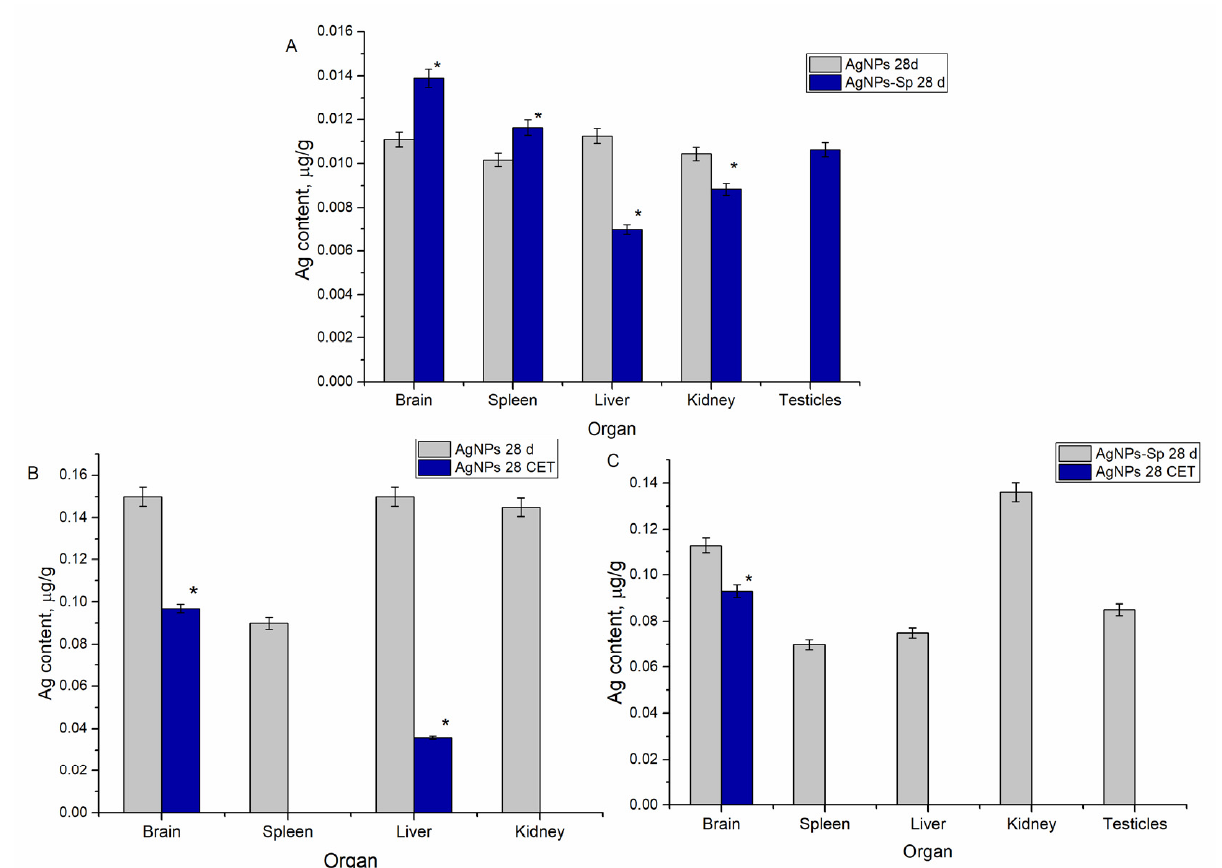
Figure 3. The content of silver in rats’ organs: ( A ) animals administrated with AgNPs and AgNPs-Spirulina for 28 days, measured immediately after the end of the experiment; ( B ) animals administrated with AgNPs for 28 days with measurements after a clearance period; ( C ) animals administrated with AgNPs-Spirulina for 28 days after a clearance period. 28 CET—clearance expiry time of 28 days. * indicates p < 0.005 for the difference between neighboring